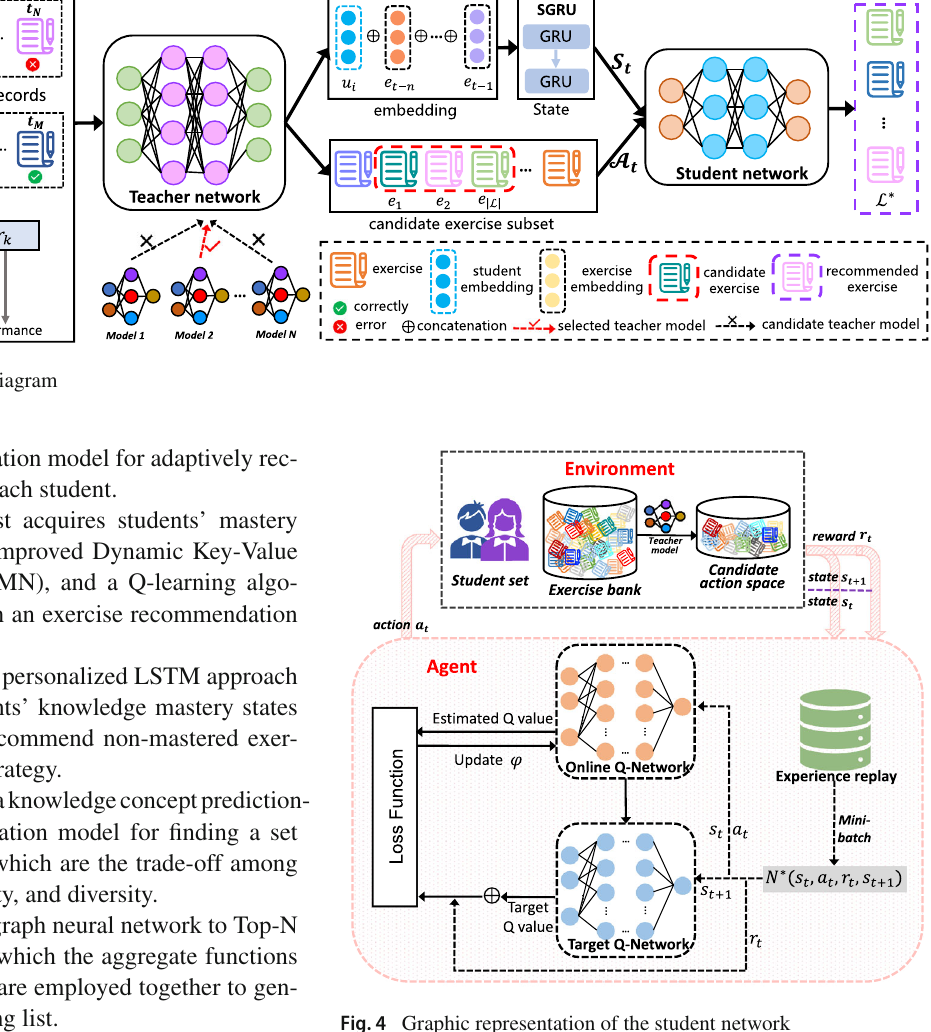
Fig. 4 Graphic representation of the student